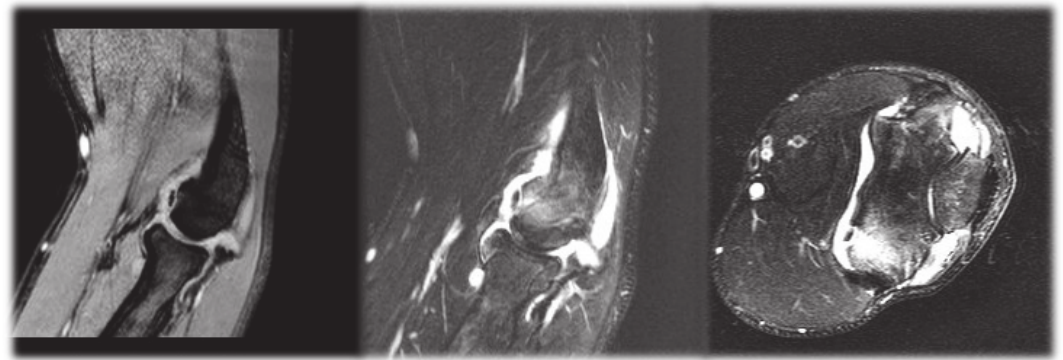
Figure 1: MRI of patients right elbow showing a small osteochondral capitellar lesion, intramedullary oedema, and an intra-articular loose body.